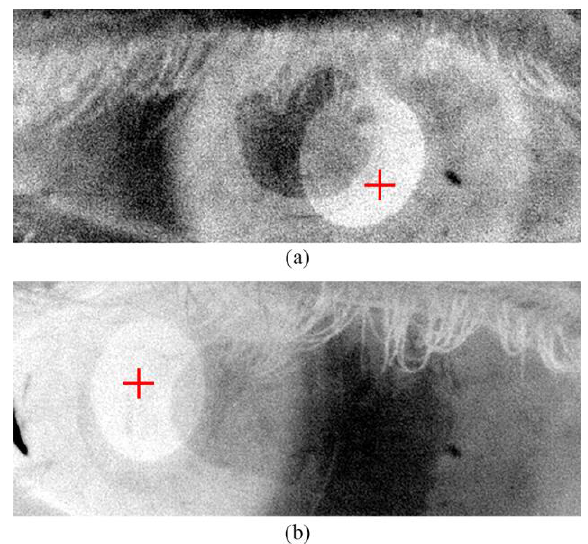
Figure 5 . Determination of the pupil position by the method of weighted average